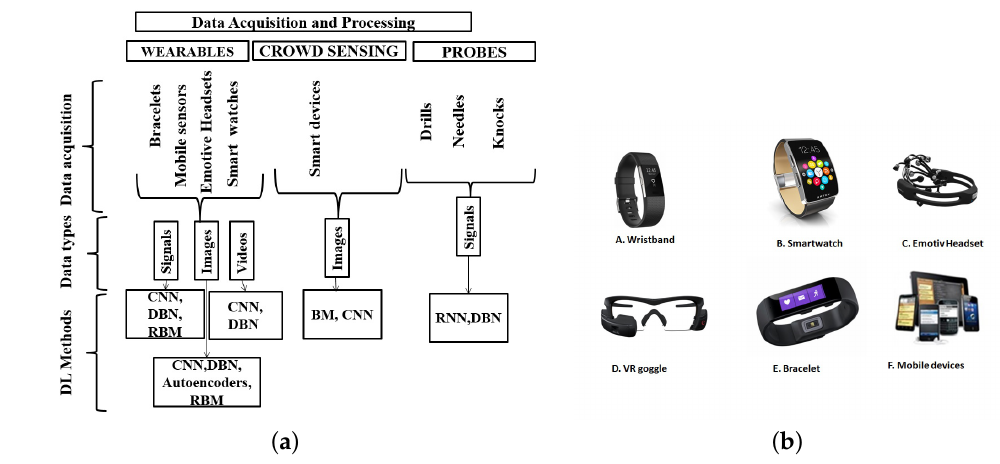
Figure 6. Data acquisition methods and processing techniques. ( a ) Taxonomy of sensory data acquisition and processing techniques; ( b ) types of